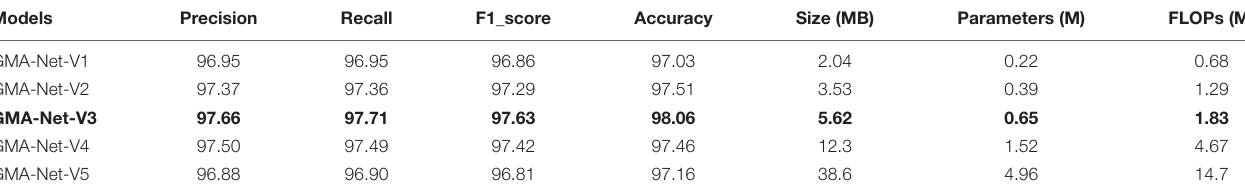
TABLE 5 | Classification results of different numbers of GMA blocks.